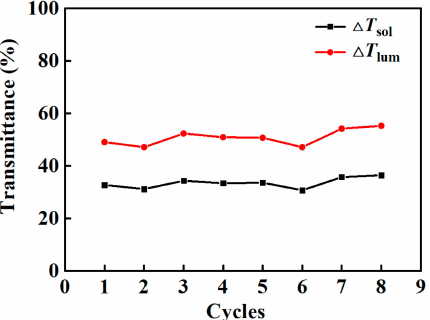
Figure 8. Changes in light transmittance at 1100 nm in the durability test of Composite 3 between 20–45 ◦